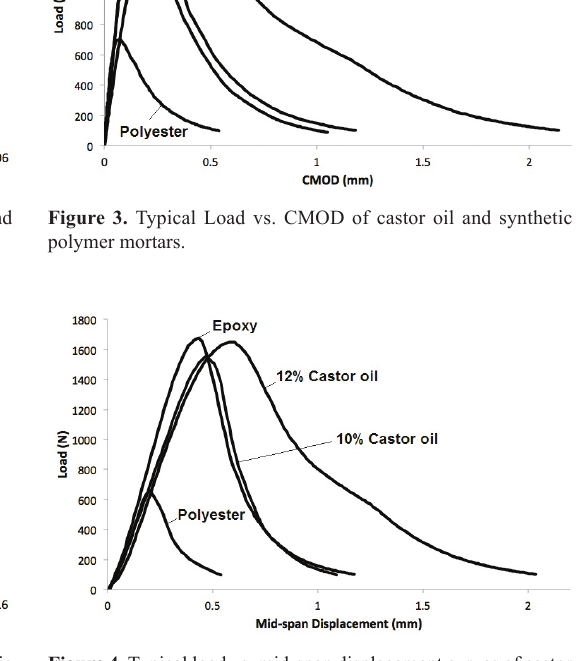
polymer mortars.